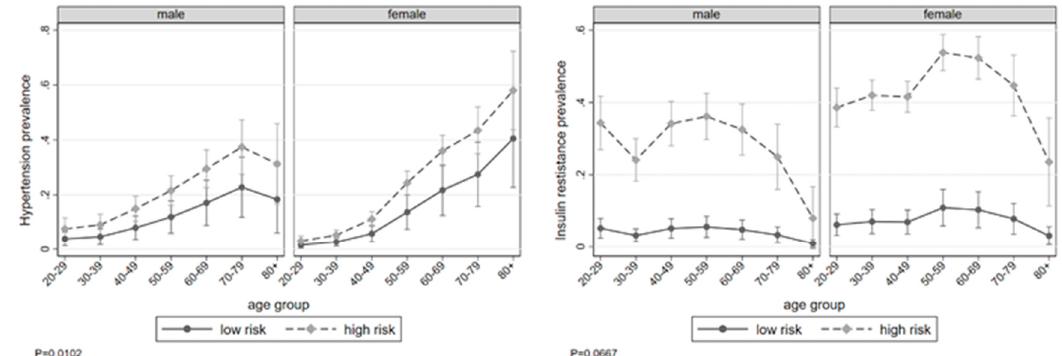
Figure 1. Age and sex interaction on prevalence rate for dyslipidemias, hypertension and insulin resistance by WHtR category for adults > 20 y, ENSANUT MC 2016, M é xico. Low risk = WHtR < 0.5; High risk = WHtR ≥